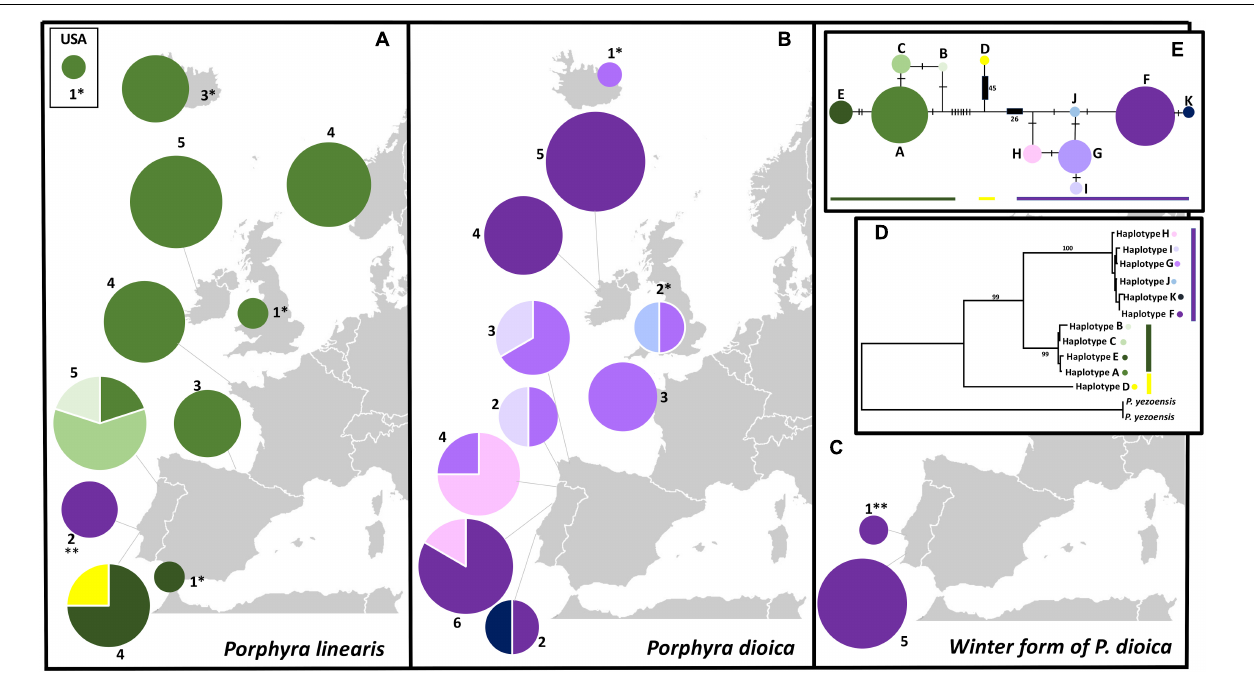
FIGURE 7 | Geographical distribution and phylogenetic relationships of rbcL haplotype sequences used in this study; (A) Geographical distribution of pie charts for P. linearis along the biogeographical range on the Northeast Atlantic (including a site from United States); (B) Geographical distribution of pie charts for P. dioica along its full biogeographical range, (C) Geographical distribution of pie chart for the winter form of P. dioica found in this study; (For all, the color key for the haplotypes found is on the right part of the figure); (D) Phylogenetic phylogram by ML based on the 11 haplotypes (plus 2 outgroups) obtained in 71 sequences of 1141 nucleotides; numbers represent bootstrap values for the consensus tree for each analyses. The evolutionary history was inferred by using the Maximum Likelihood method (ML), based on the Tamura-Nei model Tamura and Nei (1993), (E) TCS network of the 71 rbcL sequences, 9 extracted from Genbank, and 62 produced in this study. Size in each pie chart is proportional to the number of sequences that belong to one haplotype. Mutations represented by hatch marks or numbers in